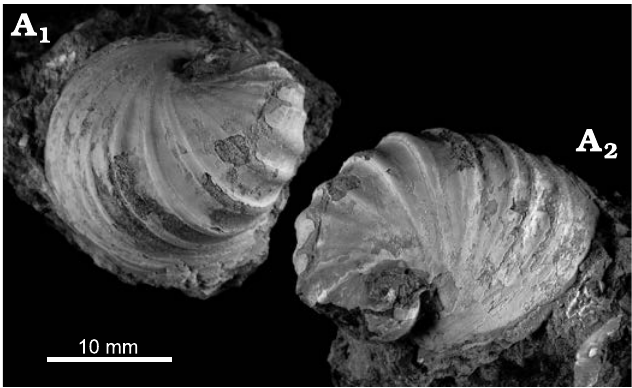
Fig. 19. The phenacolepadid gastropod Thalassonerita hagai sp. nov., from Upper Miocene seep deposits of the Amlang Formation in Pangasinan province, Luzon, Philippines. NIGSPAL-032, holotype, in abapertural view (A 1 ) and apical view (A 2